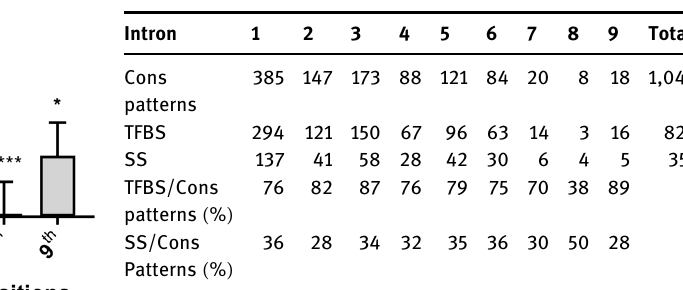
Table 1: Frequency distribution of the conserved patterns identi fi